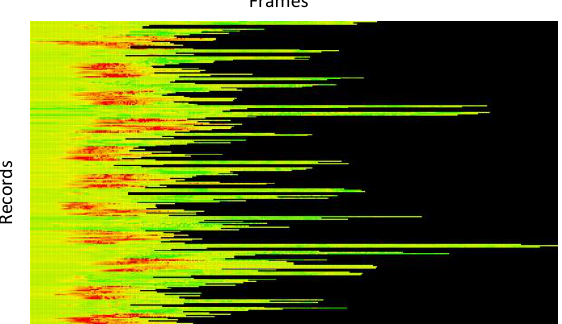
Figure 6. Representation of fall action output (red), obtained as a result of SVM classification of records of 11 persons in TST Fall Detection dataset